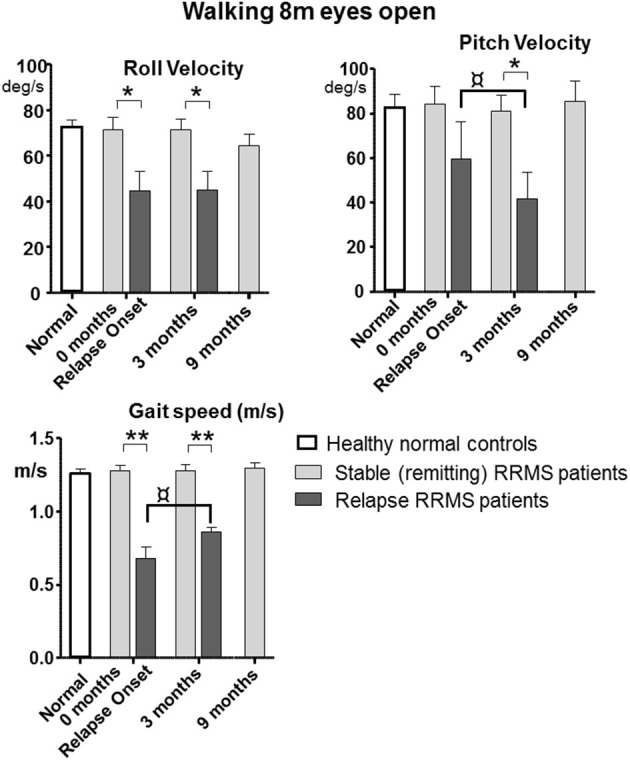
Peak-to-peak balance measures of walking 8 meters with eyes open for remitting and relapse RRMS patients as well as normal age-matched controls. Data represented as mean with sem, *p < 0.05, **p ≤ 0.001 between patient groups. ¤p < 0.05 between onset and 3 month values for relapse patients. n = 24 for remitting RRMS patients, n = 9 for relapse RRMS patients during relapse. Normal data n = 40 taken from Goutier et al. (18).